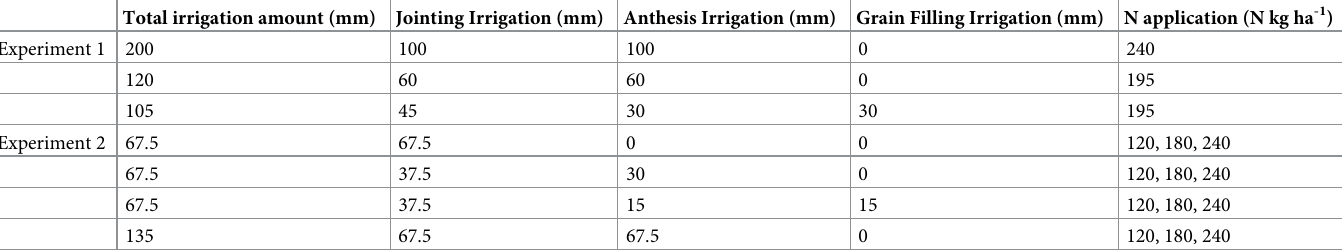
Table 1. Water and nitrogen treatments in the experiments conducted at Gaocheng, China (2013–2015).